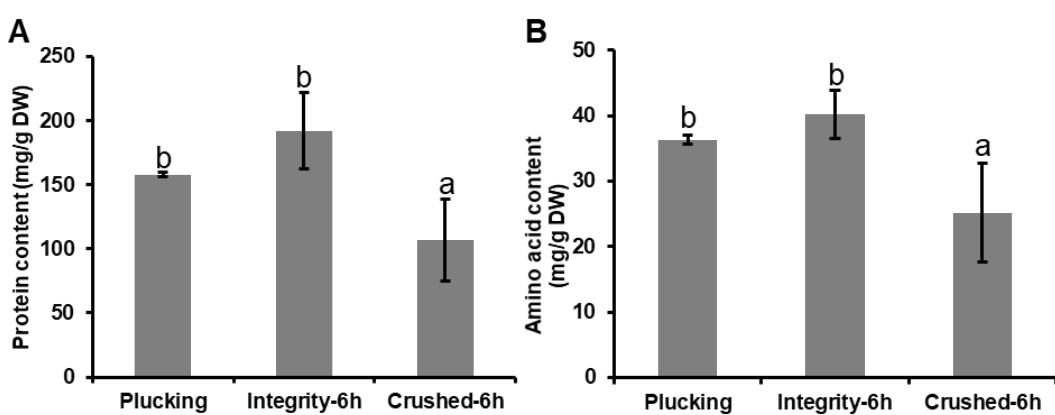
Figure 3. Changes of protein content ( A ) and amino acids content ( B ) in enzymatic reaction of black tea. Bars indicate the means ± S.D. ( n = 3) of three biological replicates, and bars with di ff erent letters are significantly di ff erent at p ≤ 0.05 according to Duncan’s multiple range test.